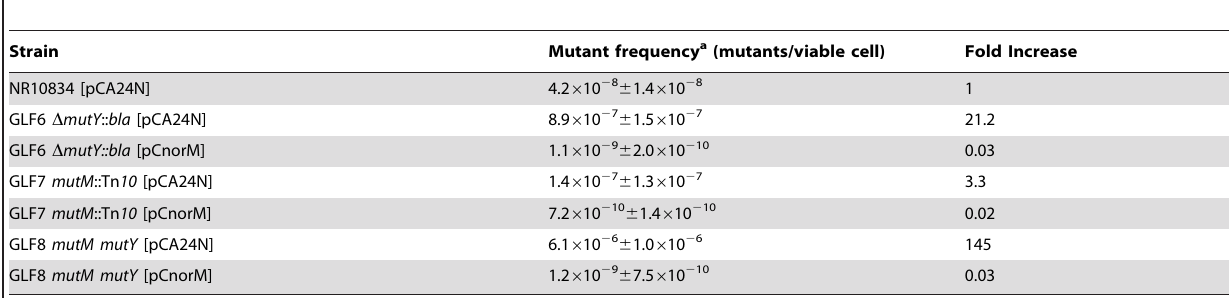
Table 4. Spontaneous Lac 2 to Lac + mutant frequencies of the wild-type and mutM , mutY and mutM mutY derivatives with or without the norM -encoding plasmid.